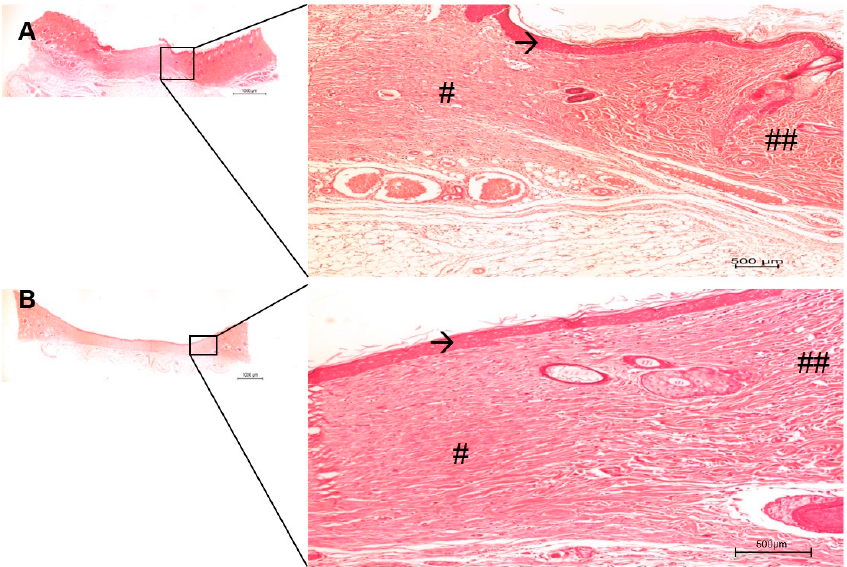
Figure 8. Histological images of the skin wound healing implanted with PVA-AgNP/col-HA, after 14 ( A ) and 28 ( B ) days. The right images are higher magnification areas from the entire lesion site depicted at left. ( → ) early epidermis; the new dermis (#) presented a fibrous pattern quite similar to the old dermis (##). Bars 1000 µm.